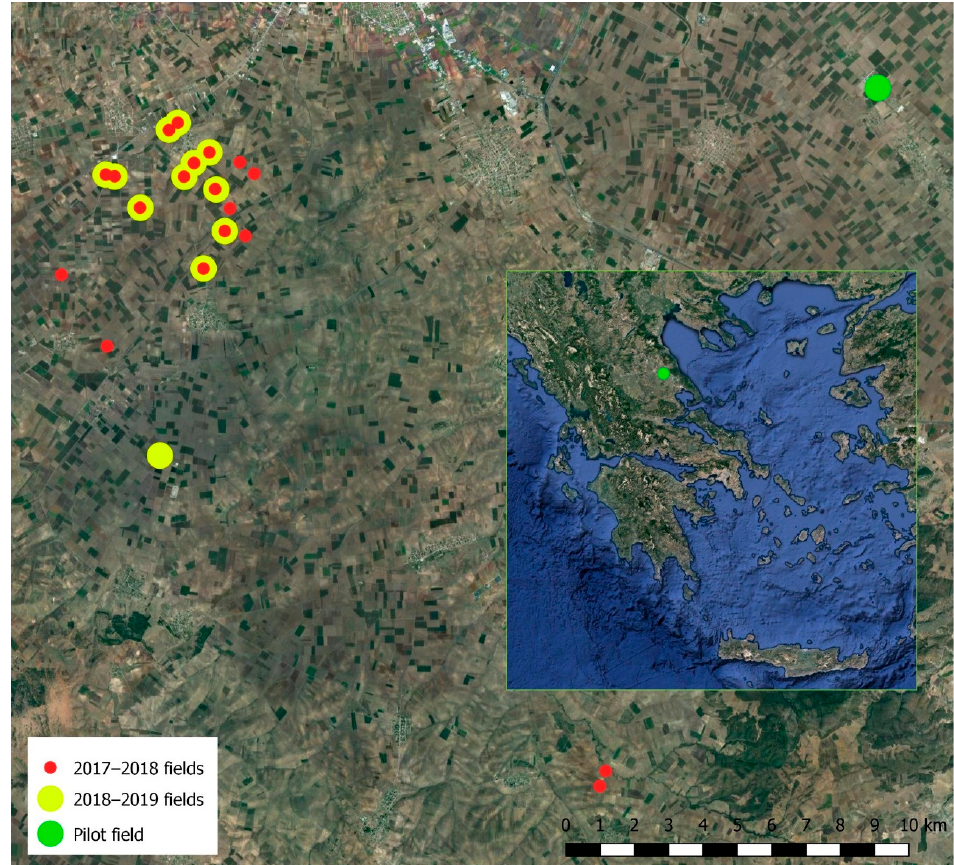
Figure 1. Satellite image of the Thessaly plain, Greece (inset), with the studied fields indicated.